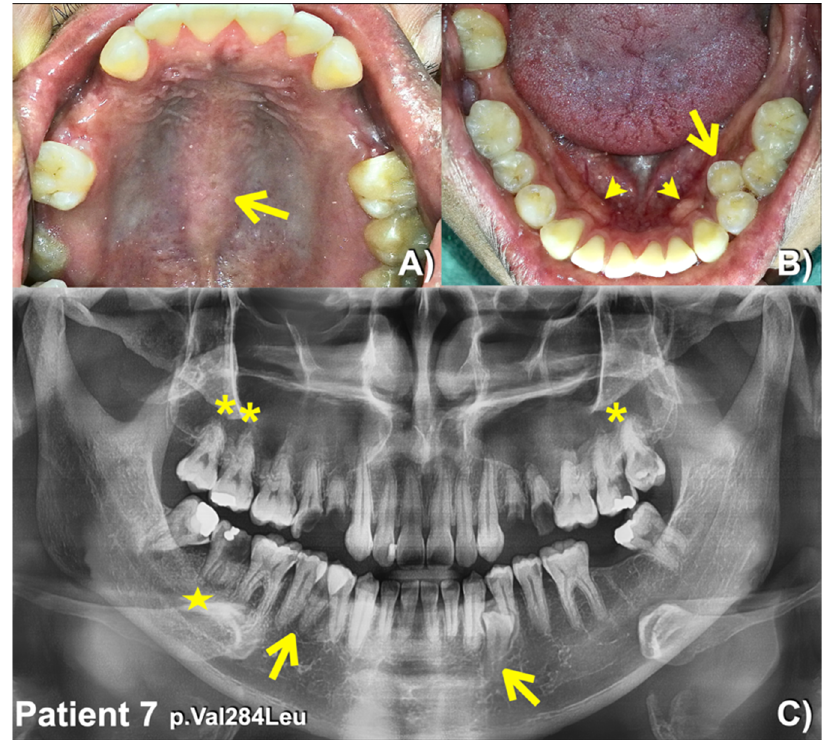
Figure 5. Patient 7. ( A ) Torus palatinus (arrow). ( B ) Torus mandibularis (arrowheads). Supernumerary left mandibular premolar (arrow). ( C ) Panoramic radiograph showing supernumerary mandibular premolars (arrows). Maxillary permanent molars with unseparated roots (asterisks). Short roots of the mandibular right second permanent molar (star).